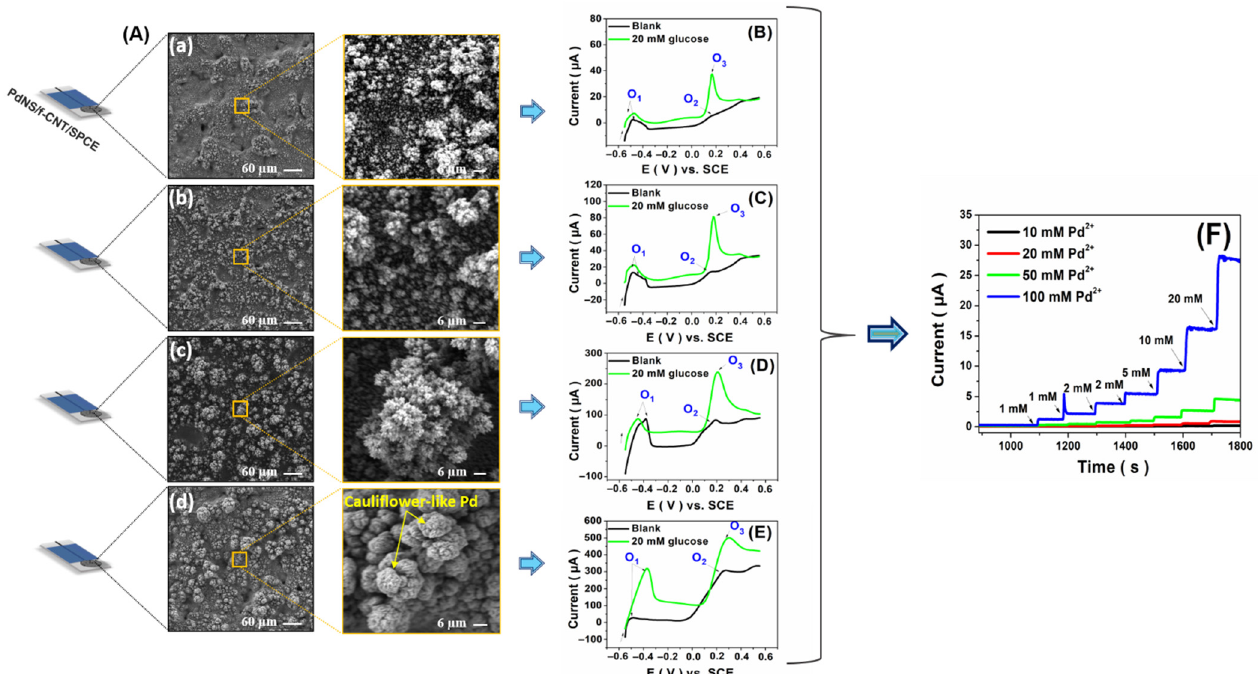
Figure 4. ( A ) SEM images: the evolution of the palladium structure shape (from clusters to cauliflower- like Pd structures) as a function of metal precursor concentration, ( a ) 10 mM, ( b ) 20 mM, ( c ) 50 mM, ( d ) 100 mM Pd 2+ . LSVs at PdNS/f-CNT/SPCE (f-CNT dispersed in Nafion:DMF of 0.1 M PBS (pH 7.4) without (black color) and in the presence of 20 mM of glucose ( green color ). All LSVs were recorded after the electrodeposition ( − 0.2 V vs. SCE, 300 s) of the PdNS catalyst in a 0.05 M HClO 4 and